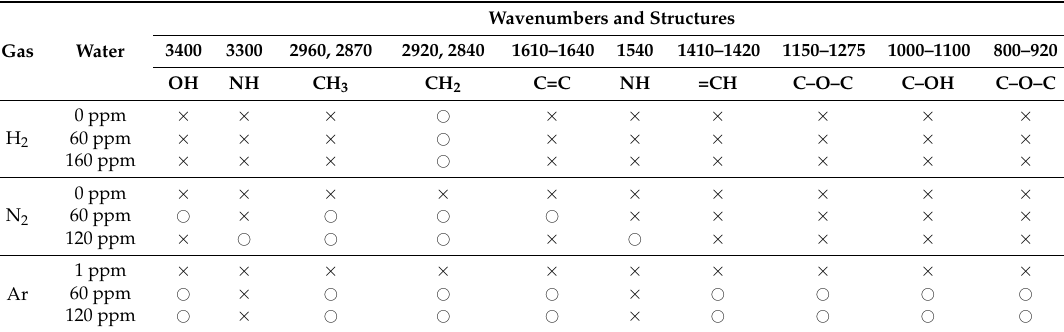
Table 2. Peaks found in FT-IR spectra on pins slid against a-C:H DLC.